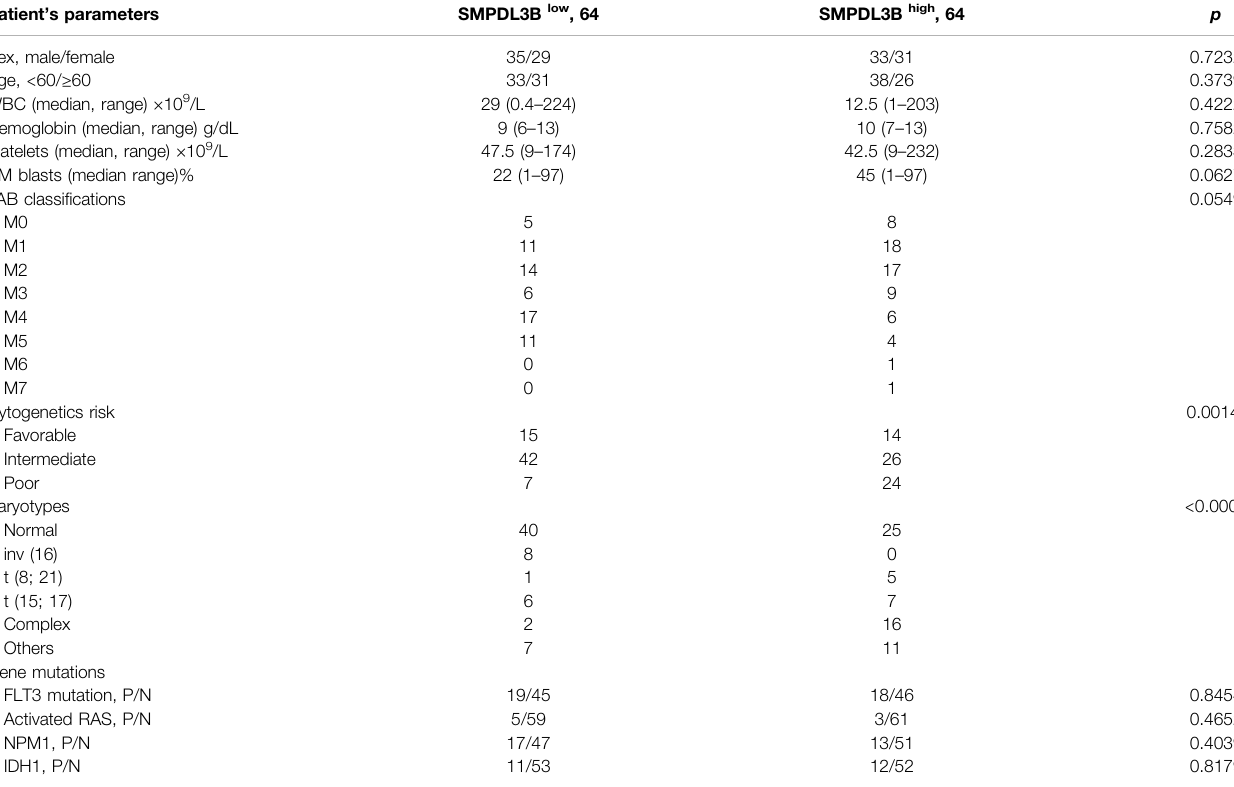
TABLE 1 | Association between SMPDL3B expression and clinicopathological characteristics in AML patients.